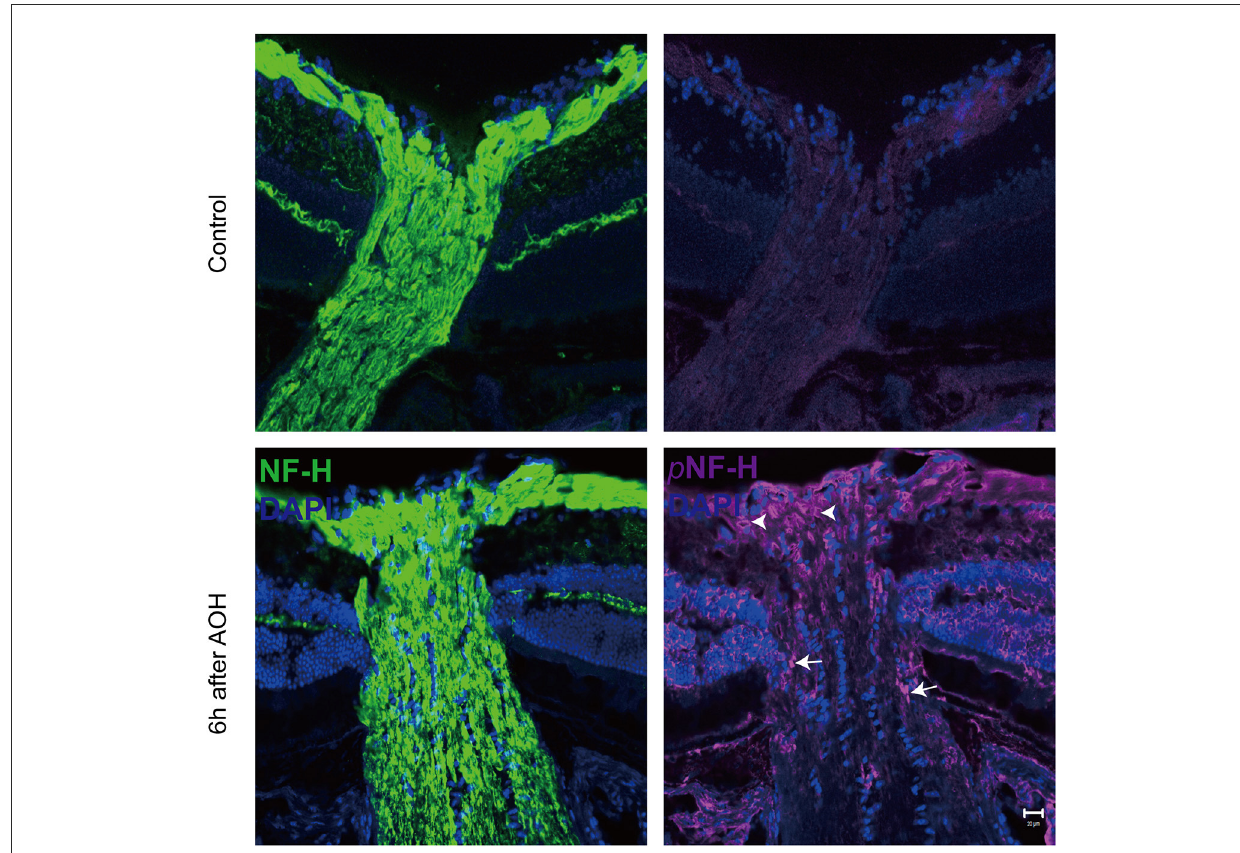
FIGURE5 Phosphorylated neurofilament heavy chain (pNF-H) presented as intra-axon plaque and vacuolization at the site of ONH after an acute attack. Immunofluorescence of pNF-H and NF-H in the ONH 6h after AOH. The arrowhead shows the vacuolization, while the arrows show the plaque. Scale bars: 20 µ